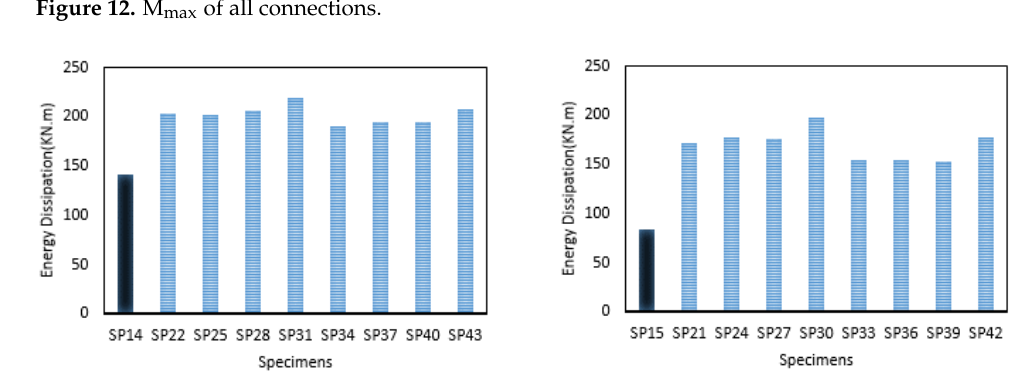
Figure 13. ED capacity of all connections.